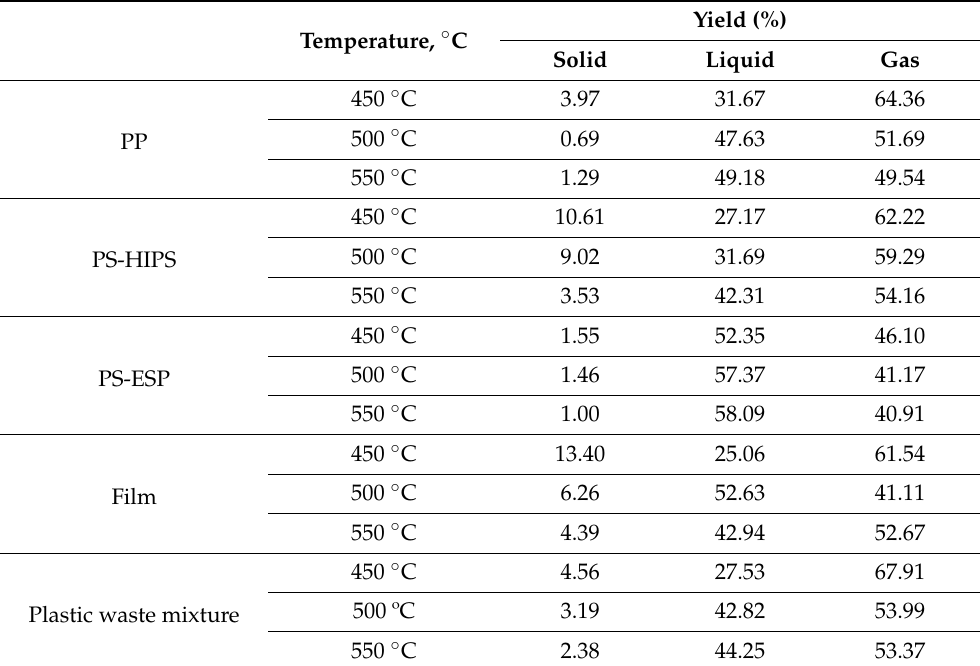
Table 3. Yields to products obtained in the pyrolysis tests with the different plastic